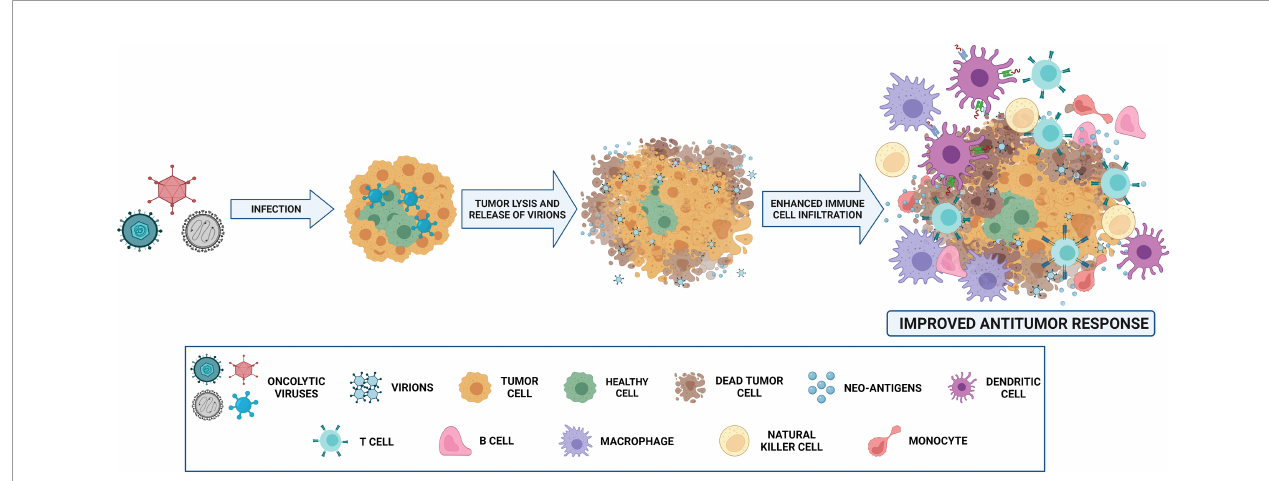
FIGURE 2 | Mechanism of action of oncolytic viruses (OVs). OVs, administered intravenously or intratumorally, infect normal and tumor cells. Nevertheless, they replicate only in malignant cells, and virion release then occurs. The infection and destruction of tumor cells lead to the release of antigens that cause proin fl ammatory recruitment of different immune cells, such as T and B cells, macrophages, NK cells, monocytes and dendritic cells. Thus, antitumoral effect is mediated not only by oncolytic capability, but also by immune microenvironment reshaping. Created with